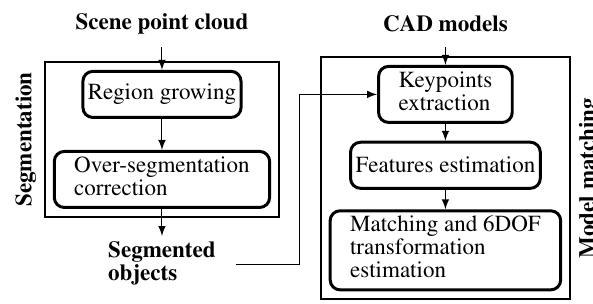
Figure 3. Overview of the proposed